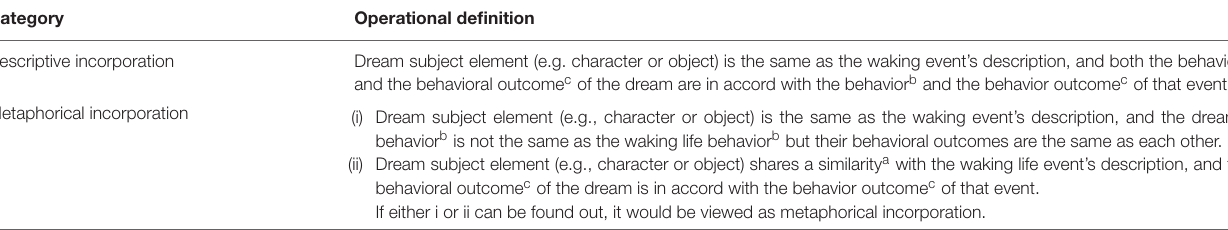
TABLE 1 | Operational definition for different kinds of